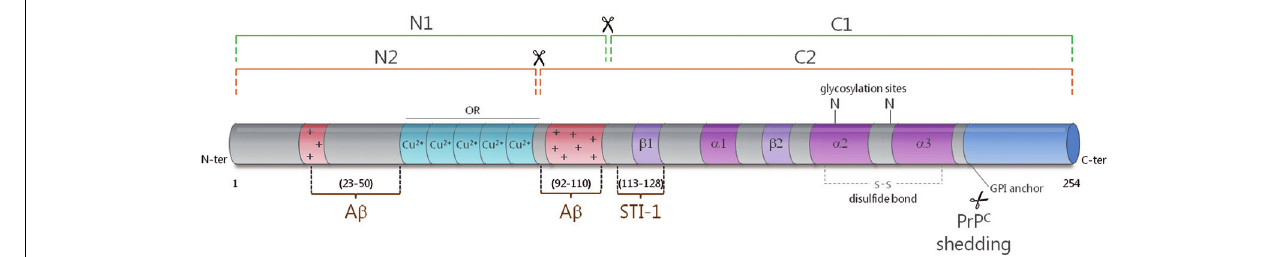
FIGURE 1 | Schematic representation of the secondary structure of PrP c . The alpha-cleavage (green) occurs at position 111/112 and generates the N1 and C1 fragments.The beta-cleavage (orange) occurs in the vicinity of octapeptide repeats (ORs), which bind copper ions, and generates the N2 and C2 fragments. PrP c can also be shed from the plasma membrane through the